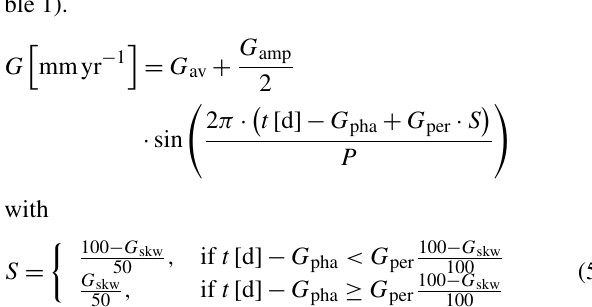
Contrary to previous δ 18 O c growth models, ShellChron al- lows uncertainties in the input variables (sampling distance and δ 18 O c measurements) as well as uncertainties of the full modeling approach to be propagated, providing confidence envelopes around the chronology. Uncertainty propagation is optional and can be skipped without compromising model accuracy. Standard deviations of uncertainties in input vari- ables (sampling distance and δ 18 O c ) can be provided by the user, while model uncertainties are calculated from the vari- ability in model results of the same data point obtained from overlapping simulation windows (see growth_model func- tion). Measurement errors are combined by projecting Monte Carlo simulated values for sampling distance and δ 18 O c mea- surements on the modeled δ 18 O c curve through an orthog- onal projection (Eq. 6; mc_err_orth function; visualized in Fig. S3). The measurement uncertainty projected on the dis- tance domain is then combined with the model uncertainty to obtain pooled uncertainties in the distance domain, which are propagated through the modeled δ 18 O c record to obtain uncertainties in the model result in the age domain. As a